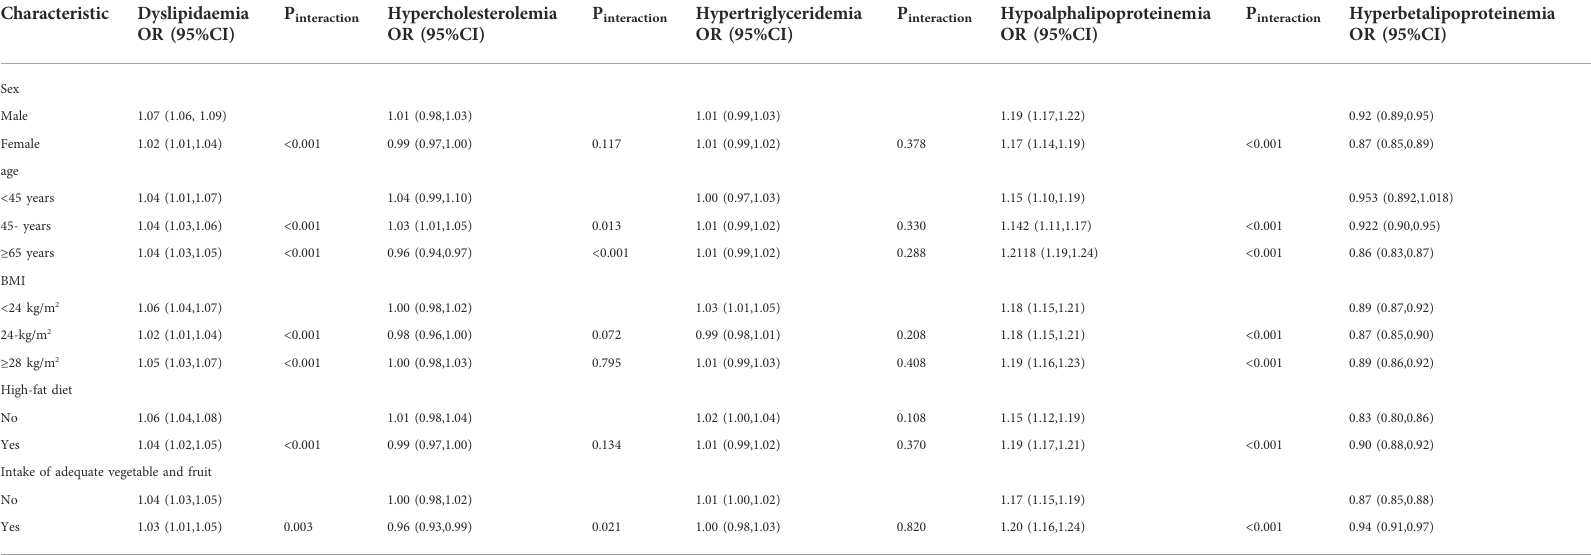
TABLE 3 Interactions of age, sex, and BMI on relationships between a 1- μ g/m 3 increase of PM 2.5 and